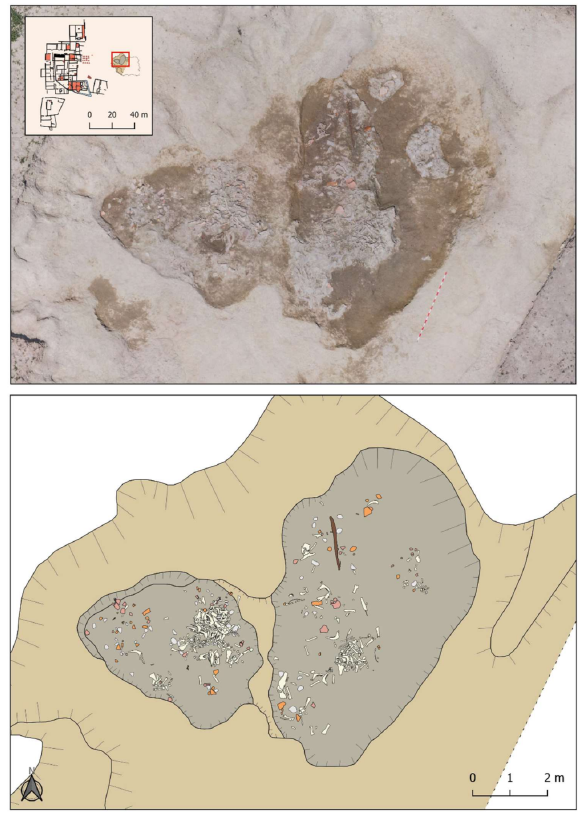
Figure 5. Pit ground